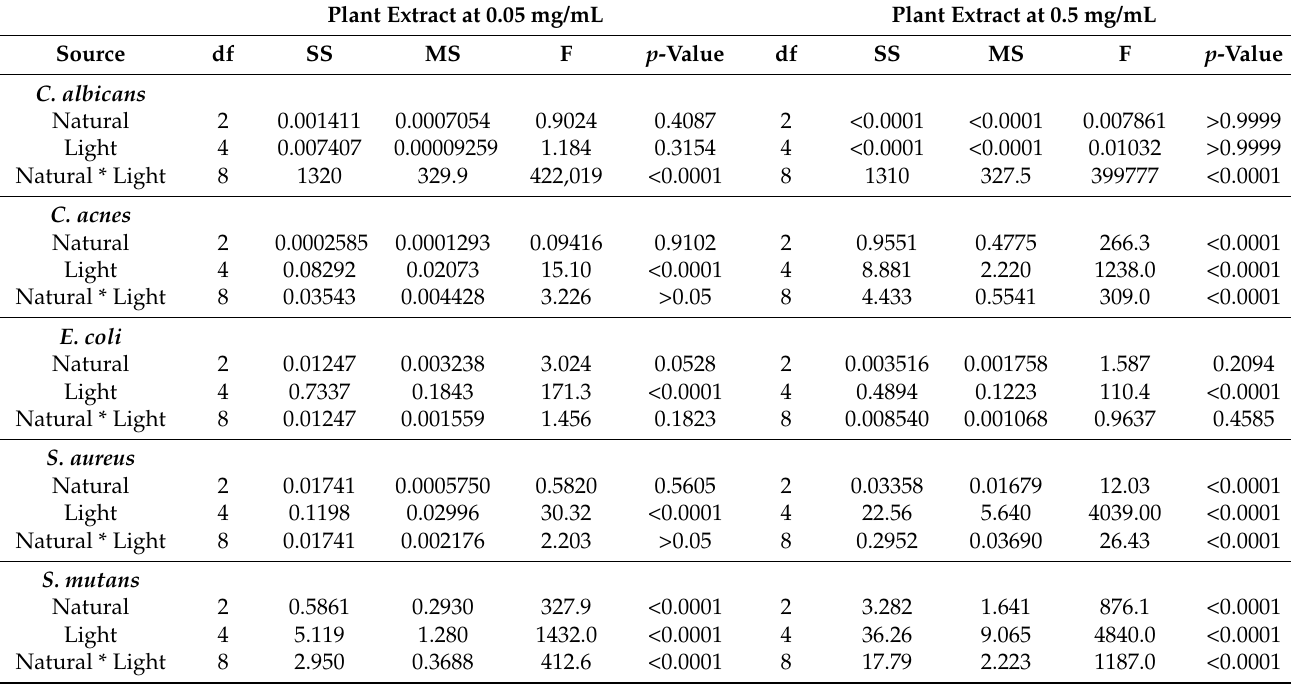
Table 4. Summary of two-way ANOVA results for bacterial viability in microbial biofilm after PDT with plant extracts (0.05 mg/mL or 0.5 mg/mL). The analyzed variables were natural substances (“Natural”) and exposure to light (“Light”). Plant Extract at 0.05 mg/mL Plant Extract at 0.5 mg/mL